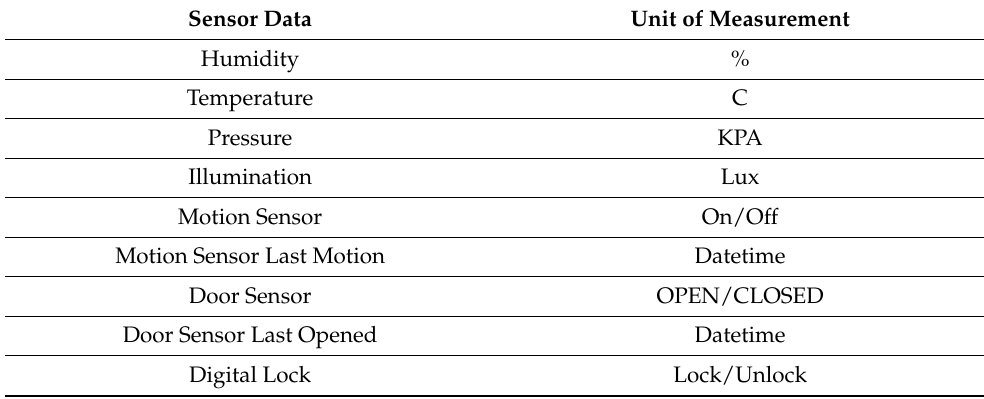
Table 1. Sensor data and unit of measurement of the use case.